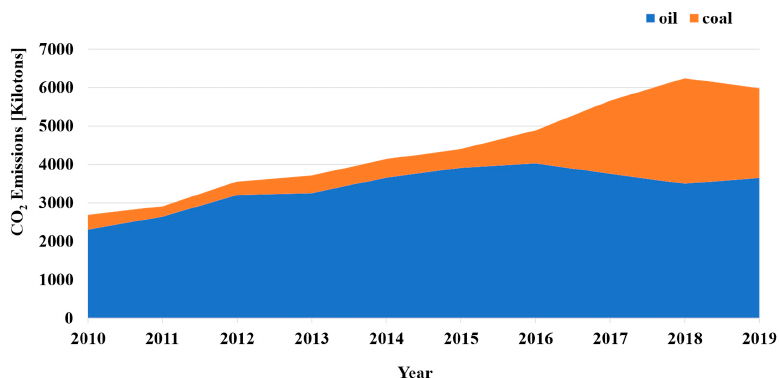
Figure 1. Trends of CO 2 emissions from different fossil fuels (adapted from [5]).